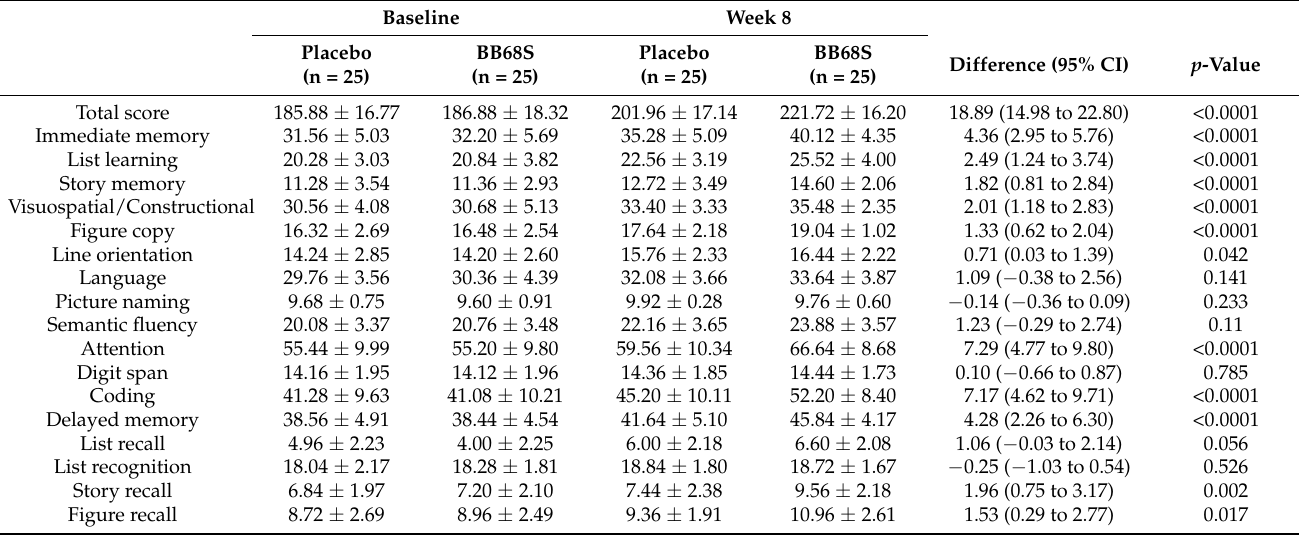
Table 2. The effects of BB68S on RBANS